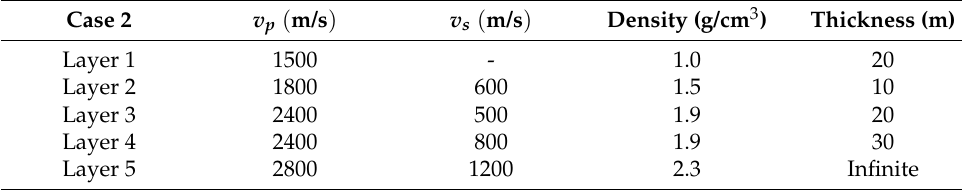
Table 2. Parameters of layered ocean Model 2.